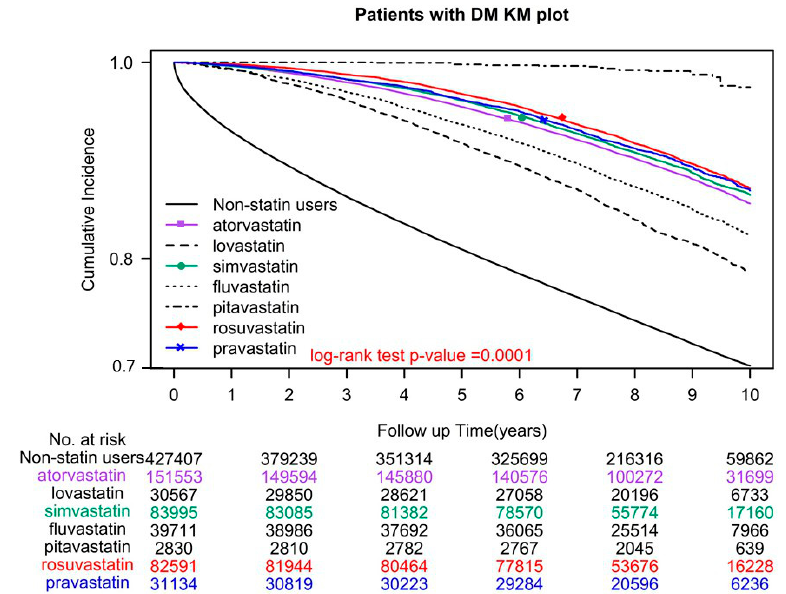
Figure 1. Kaplan–Meier overall survival curves of patients with type 2 diabetes who used different classes of statins.